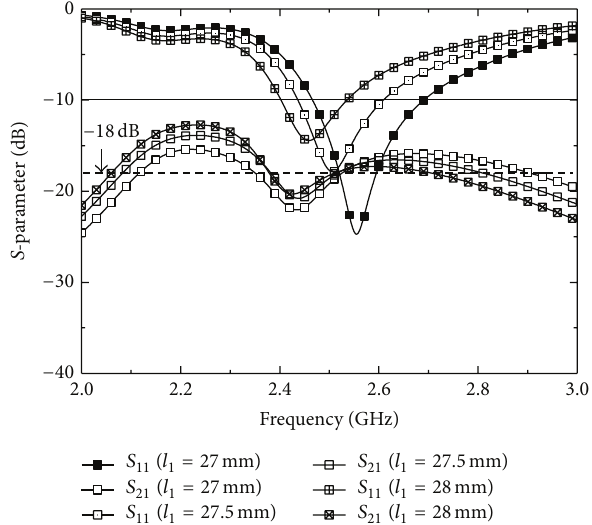
Figure 6: Simulated 𝑆 -parameter results for various values of length